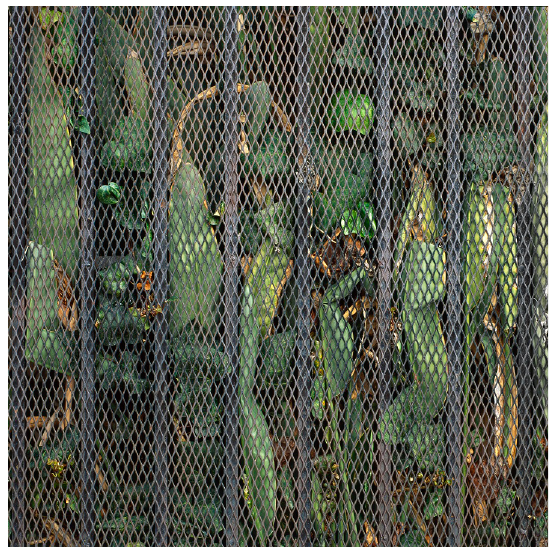
Figure 26. Anthony Hernandez, After L.A. # 39 (1938), © Anthony